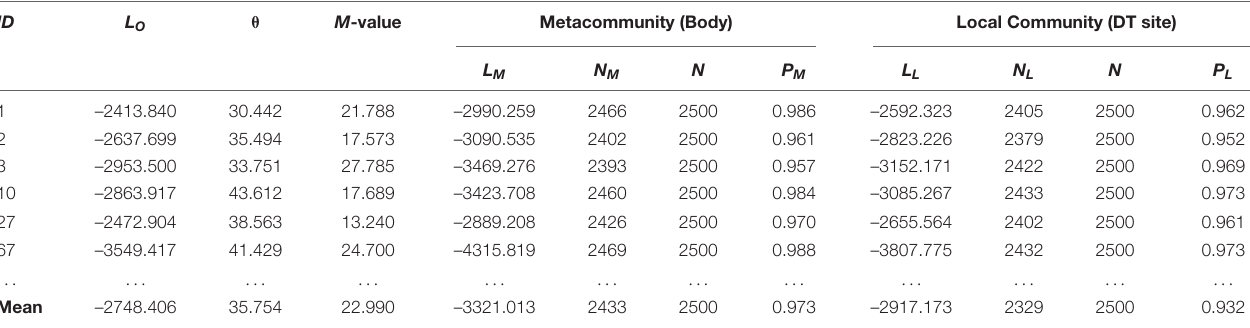
TABLE 1 | The selected test results of fitting Harris et al.’s (2017) HDP-MSN (hierarchical Dirichlet process approximated multi-site neutral model) to the microbiomes of human digestive tract (DT), excerpted from Supplementary Table 1 in the OSI where the full fitting results from 1000 times of re-sampling were exhibited